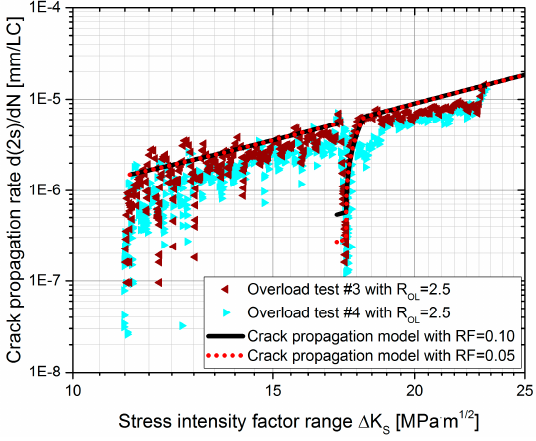
Figure 11. Comparison of crack propagation model with results of Overload test #3 and #4.